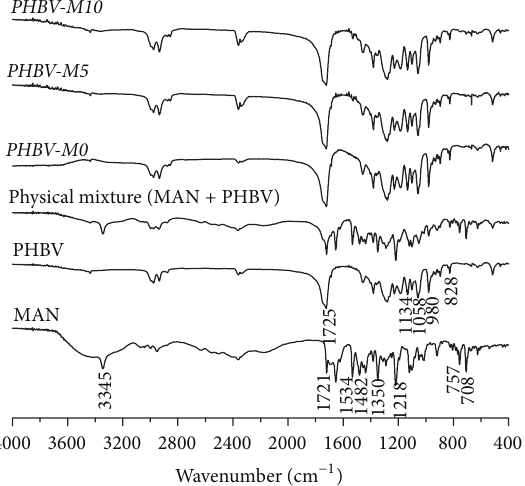
Figure 7: Release profiles of MAN and MAN-loaded microparticles into acetate buffer (50mM, pH 4.0).